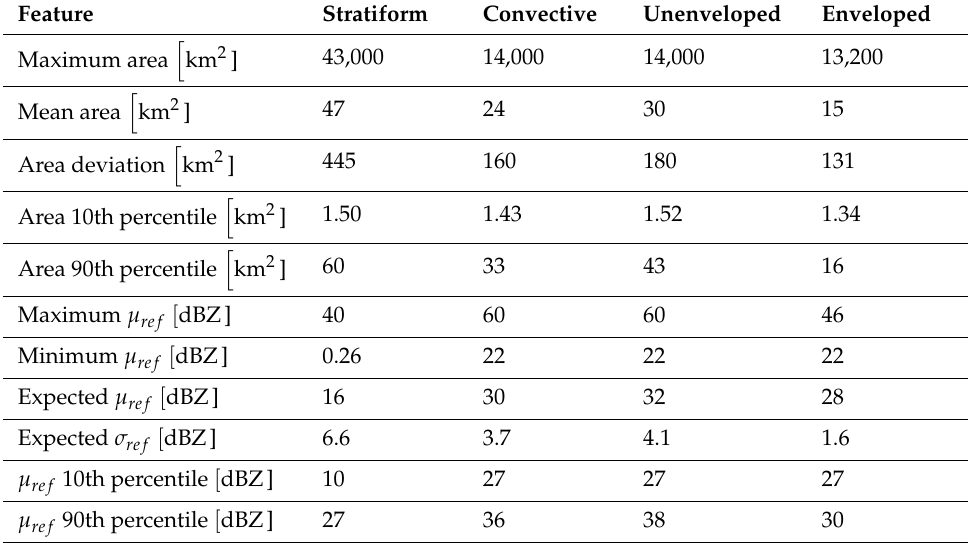
Table 1. Summary values of the systems identified.